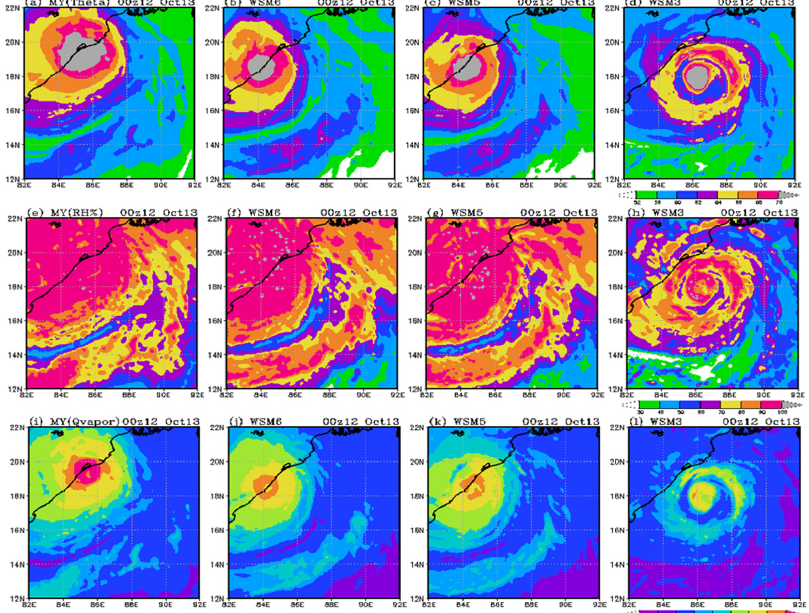
Figure 8. Model-simulated equivalent potential temperature (°C) at 700 hPa level derived from WRF (D02) experiments using ( a ) MY, ( b ) WSM6, ( c ) WSM5, and ( d ) WSM3 schemes valid at 00 UTC, 12 October, 2013. Figures ( e – l ) are the same as ( a – d ), but represent relative humidity (%) and water vapor mixing ratio (×10 3 ; gm·kg − 1 ) respectively. Oceans 2021 , 2 , FOR PEER REVIEW The east–west vertical cross-section of temperature anomaly (°C), horizontal wind speed (ms − 1 ), and direction of Phailin at the ESCS stage valid at 00 UTC, 12 October 2013 are represented in Figure 10. The positive temperature anomaly indicates the shift of warming in the middle to upper tropospheric levels (600–150 hPa) during the ESCS stage of Phailin. The MY scheme simulated that maximum warming of 5 °C persisted above 500 to 200 hPa level (Figure 10a). However, an extra amount of warming was simulated in WSM6 (Figure 10c), WSM5 (Figure 9e), and WSM3 (Figure 10g) schemes over 400–300 hPa compared to the MY scheme.